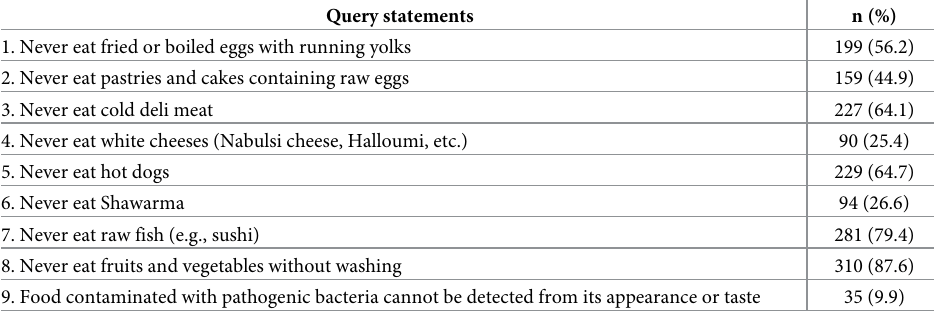
Table 6. Query statements and responses 1 to the “food consumption and safety” aspect (n = 354).